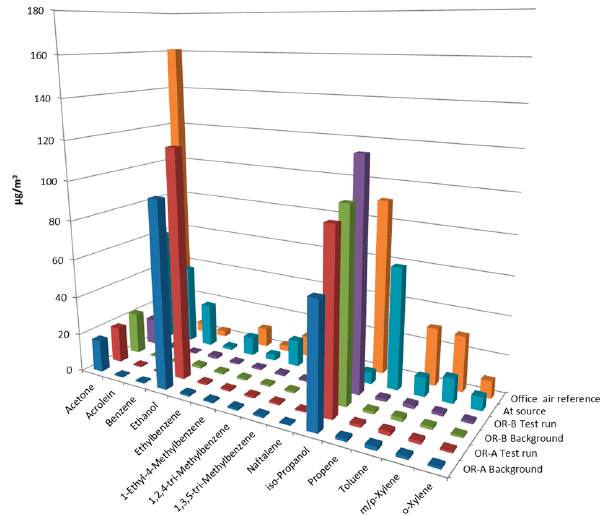
Figure 4. Impact of emissions from diesel-fueled power supply unit on indoor air concentrations of VOC before and during power supply test runs in two ORs. Concentrations at the source (100 cm from end-of-tailpipe in open air) and office air (95 percentile values) are presented as references (see Table S6); Office air reference is AGöF guidance value